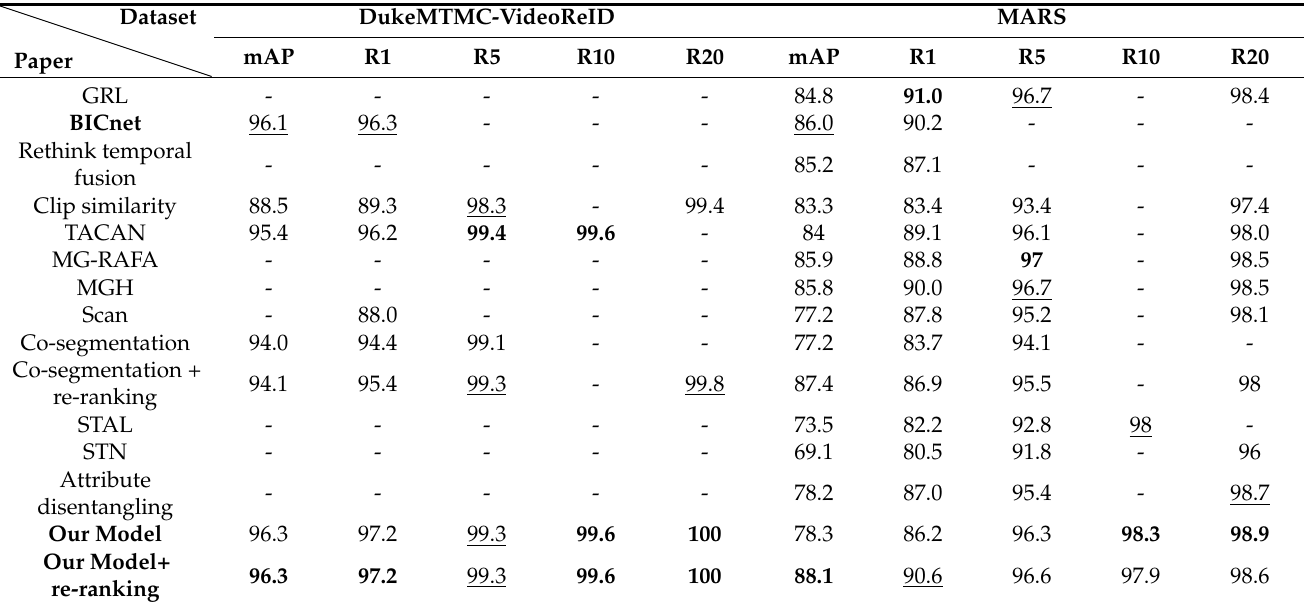
Table 4. Comparing the Models’ Performances Using Large-Scale Datasets.